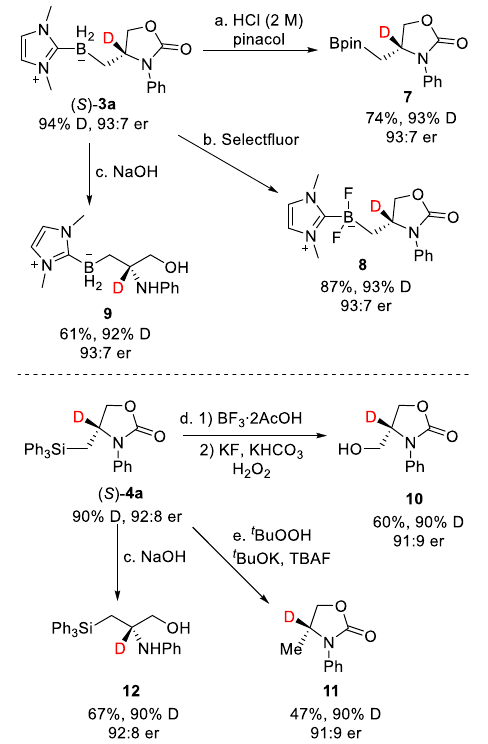
Fig. 4 | Product derivatization. See Supplementary Note 2.4 for experimental